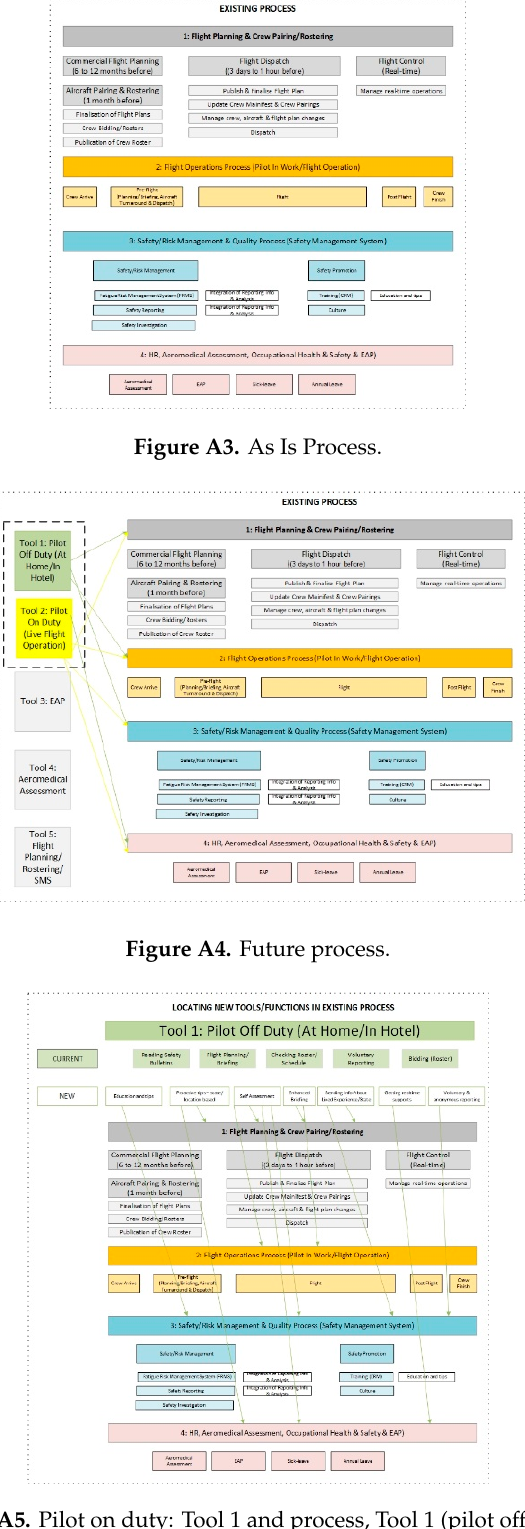
Figure A5. Pilot on duty: Tool 1 and process, Tool 1 (pilot off duty).